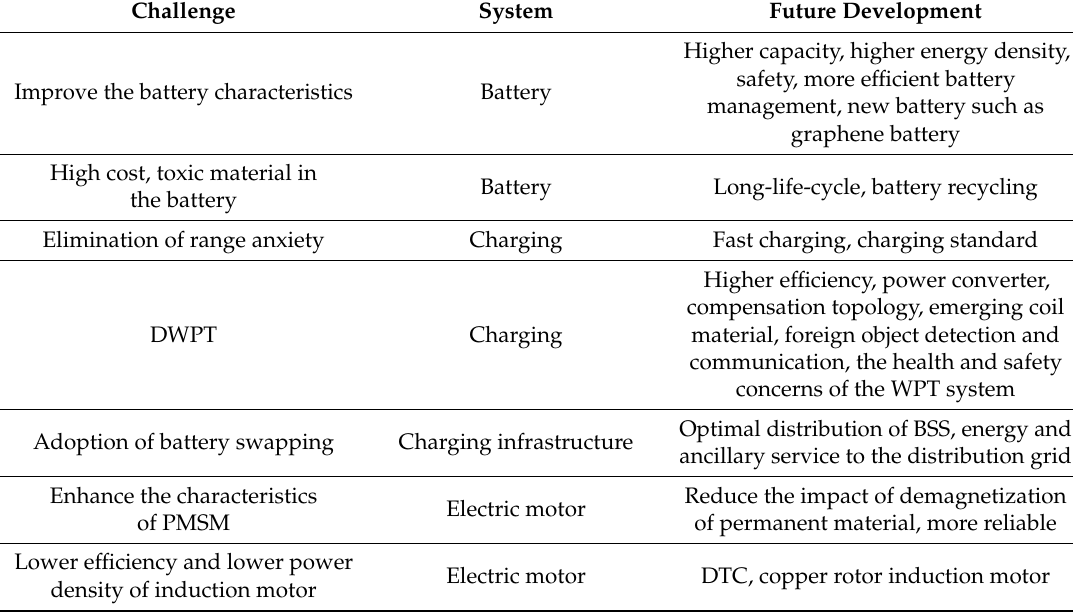
Table 5. Challenges for EV technology